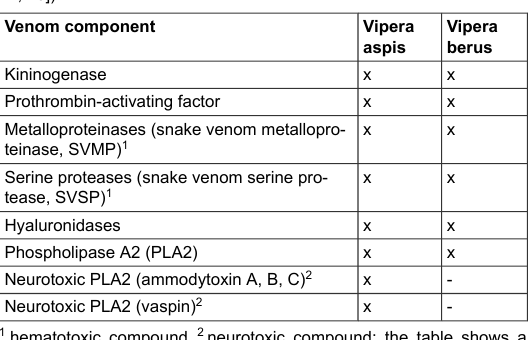
Table 4: Venom composition of V. aspis and berus (selection, adapted from [4, 14,